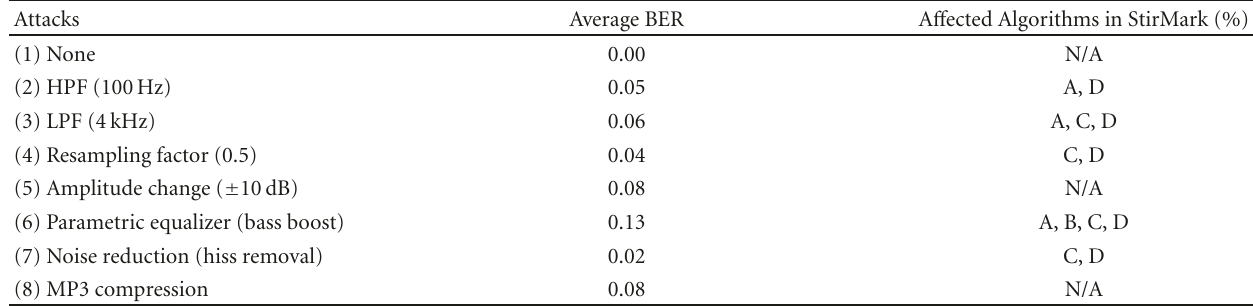
Table 4: Performance of the IMF-based algorithm after various